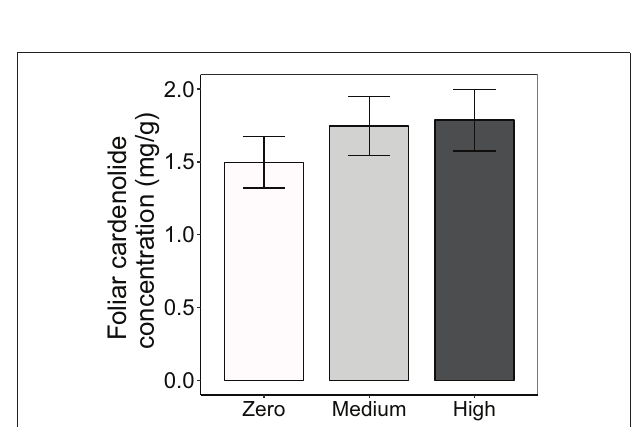
FIGURE 4 | Effects of AMF inoculation on foliar cardenolide concentrations of three milkweed species. Samples sizes range from 58 to 59 plants per AMF treatment. Bars display the mean ± 1SE. Foliar cardenolide concentrations vary among AMF treatments ( P = 0.0538), but treatment means are not significantly different at P < 0.05 (Tukey post-hoc test of the